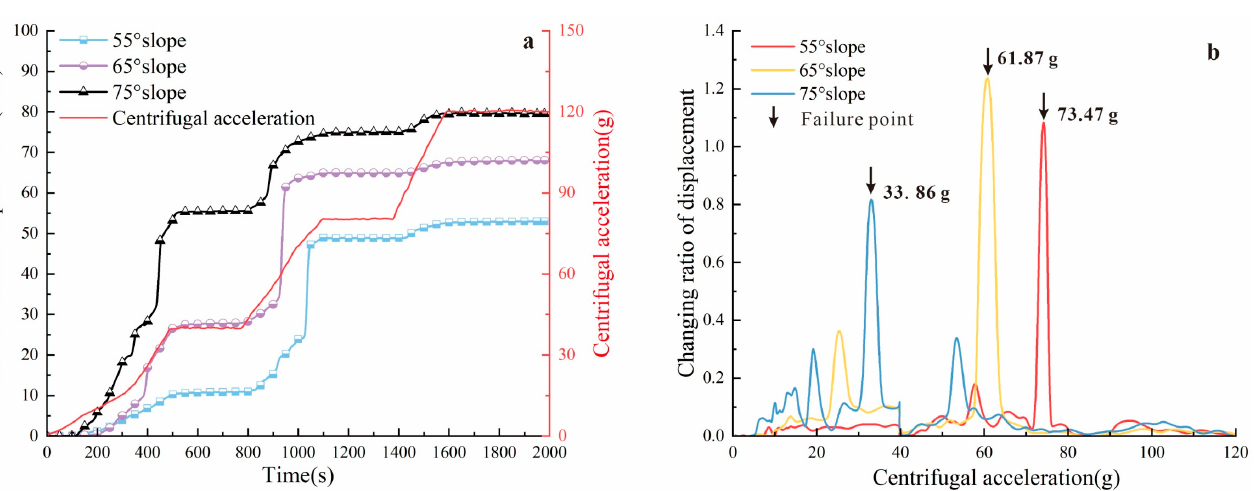
Figure 9. Curve of LVDT3 monitoring point, ( a ) displacement vs. time, ( b ) displacement changing ratio vs. centrifugal acceleration.